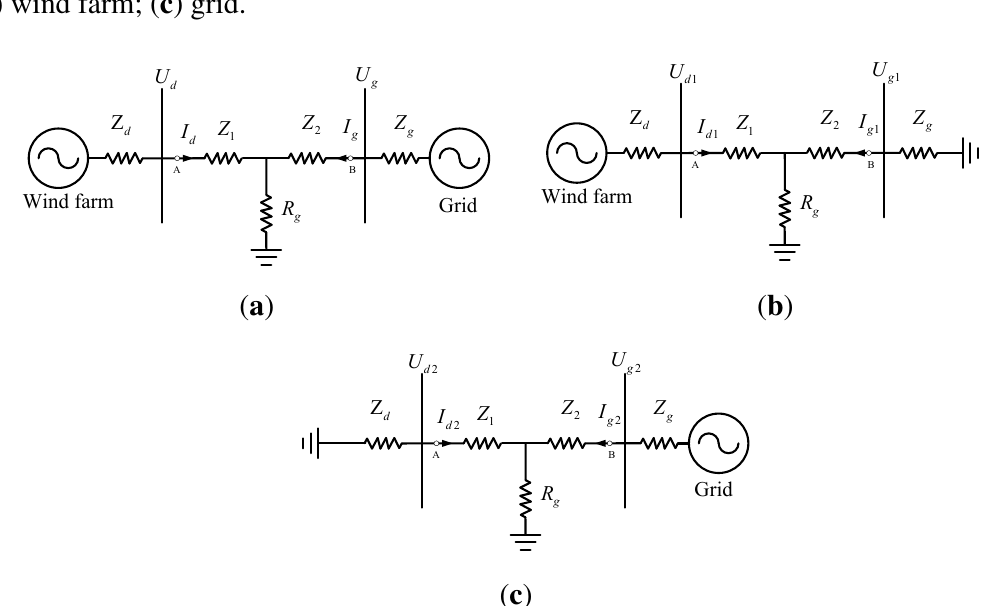
( a ) Wind farm and